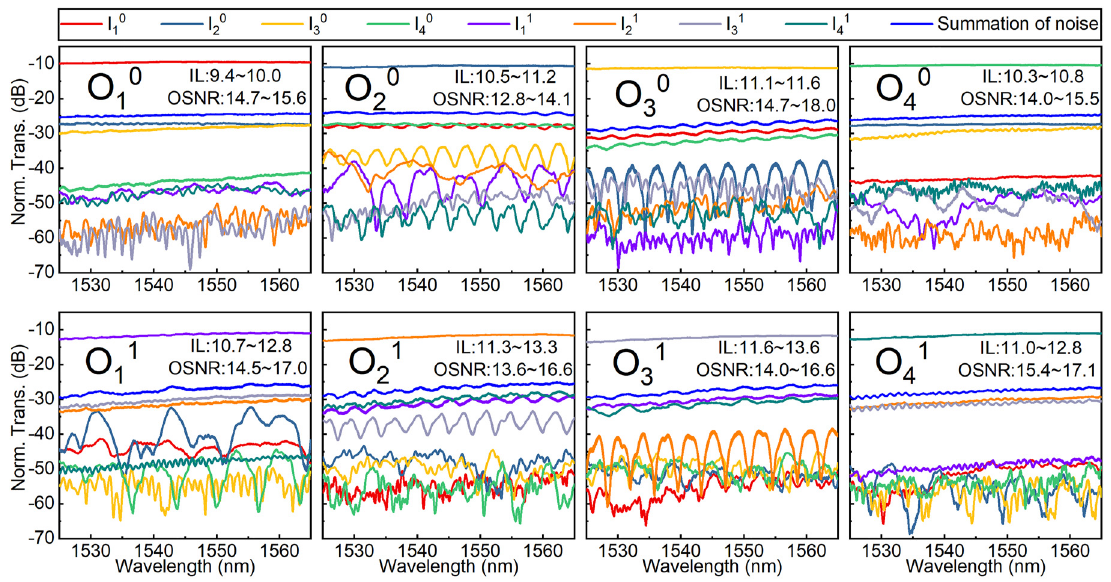
Figure 6: Normalized transmission spectra of the dual-mode 4 × 4 optical switch in the ‘‘through’’ state.